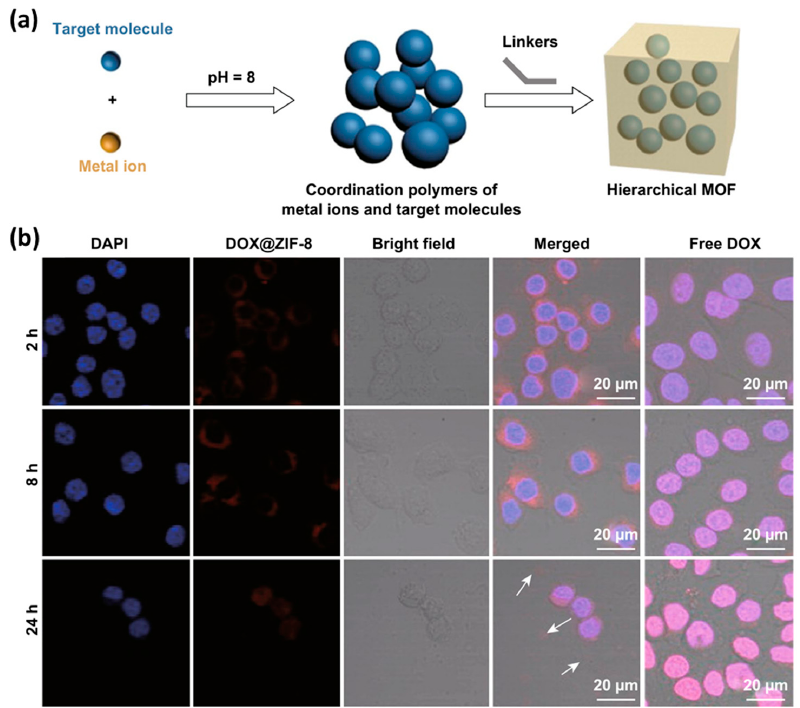
Figure 6. ( a ) Schematic illustration of the one–pot synthesis of drug–loaded ZIF–8 nanoparticles. ( b ) Cell uptake experiments showed localizations of DOX@ZIF–8 and free DOX in the cancer cells. Reproduced with permission from Ref. [117]. Copyright 2016, American Chemical Society.